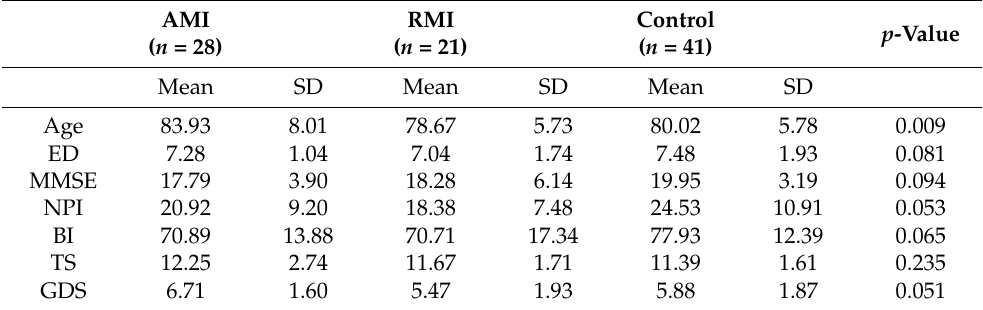
Table 1. Baseline characteristics of AD residents in the groups of intervention and in the control group.